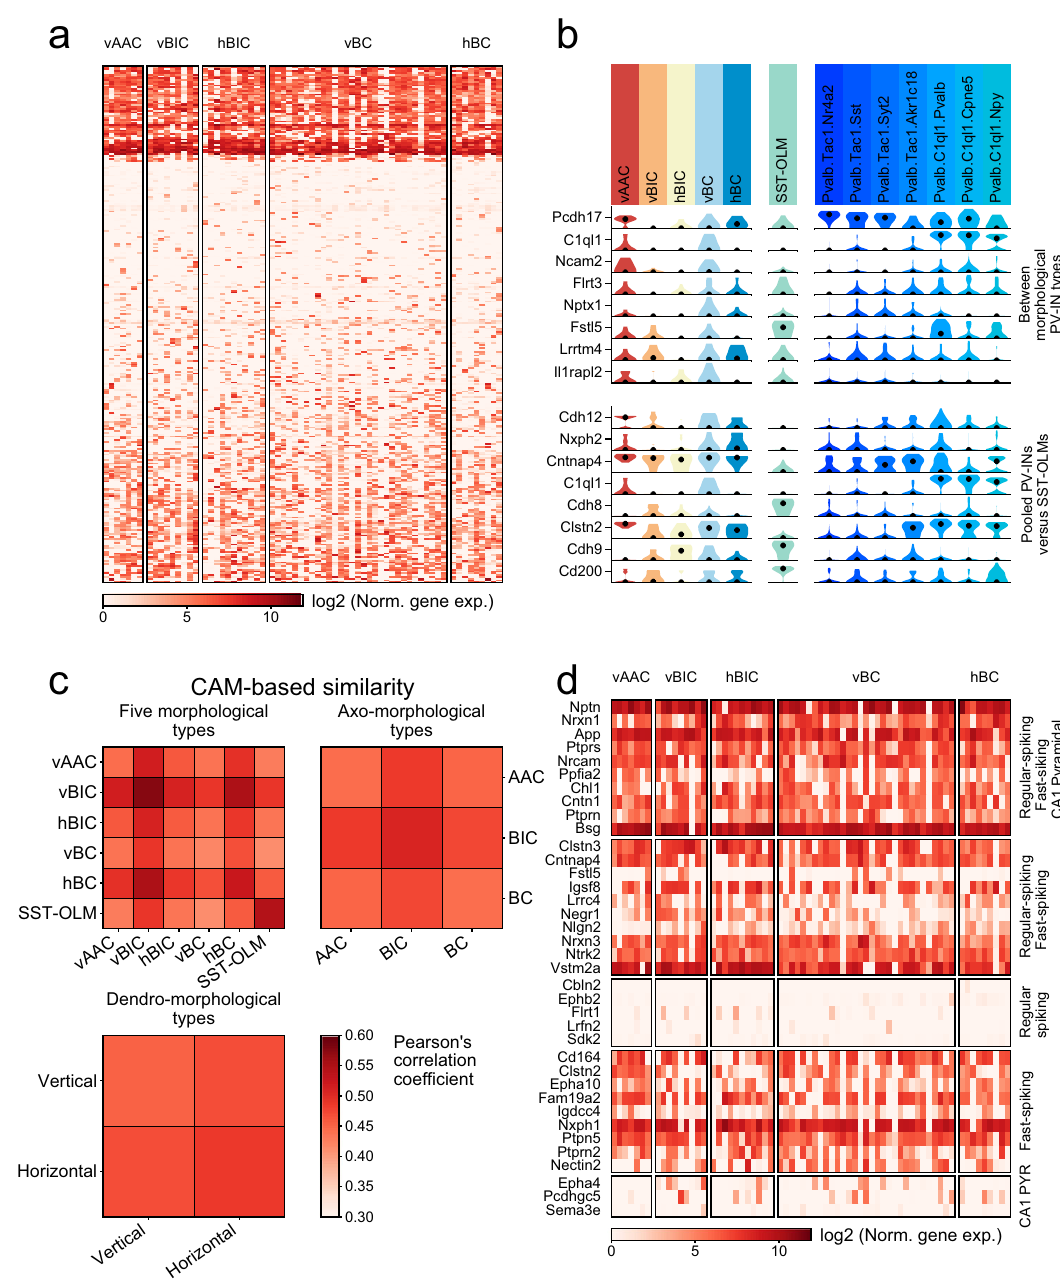
Fig. 5 Analysis of CAM expression in morphological PV types. a Heatmap showing all CAMs expressed in at least three PV-INs, grouped by morphological types. Genes are ordered via hierarchical clustering. b Violin plots show the top ten most signi fi cantly differentially expressed CAMs (using edgeR, fold difference >2), between morphological PV types (top panel), and between pooled PV-INs and SST-OLM cells (bottom panel). For comparison, relevant types from the CA1-IN study 10 are shown on the right. c Similarity matrices between the fi ve morphological (top left), three axo-morphological (top right), and two dendro-morphological PV types (bottom left). Similarity scores were measured based on only CAM expression and using the average of Pearson ’ s correlation coef fi cients of cells. d Heatmap shows an expression of genes that were previously described 13 to be (1) ubiquitous in CA1 pyramidal cells (PYR), fast-spiking interneurons (FS; presumed PV-INs), and regular-spiking interneurons (RS; presumed CCK-INs); or speci fi cally expressed in (2) FS and RS cells; (3) RS cells; (4) FS cells; or in (5) PYR predicts morphological PV-IN identities, we further investi- and horizontal type cells, and that the Pvalb.Tac1.Sst and Pvalb. gated the expression of CAMs due to their importance in Tac1.Akr1c18 subregions ( “ cluster 1 ” ) appeared to consist of specifying neuronal connectivity and their close relation to dominantly BIC-type cells. neuronal identity. However, as predicted by the above analyses, CAM expression (based on 405 genes 13 ) was uniform among the fi ve morphological PV types (Fig. 5a). Although pairwise CAM expression among morphological PV types . Although our comparisons (using edgeR, fold difference >2, FDR < 0.05) results already revealed that transcriptomics only weakly